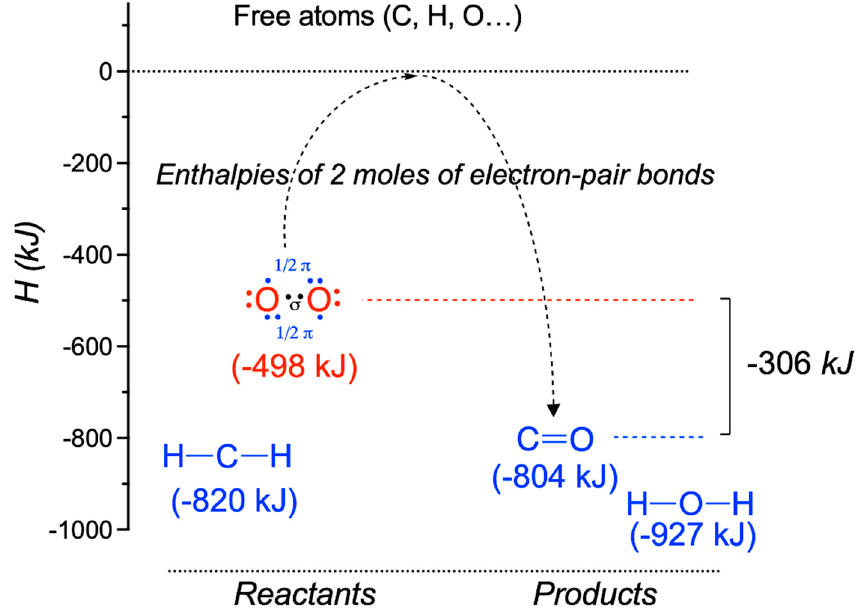
Figure 4. Bond-formation enthalpies of two moles of electron-pair bonds in O 2 and CO 2 . The bond formation enthalpies are lower (more negative) for stronger bonds [24]. O 2 is represented in the ground state of the triplet diradical dioxygen molecule with the two unpaired electrons participating in the π bonding. π electrons are shown in blue, while σ electrons are in black (modified from [24]). In other words, the weak σ bond is responsible for the thermodynamic